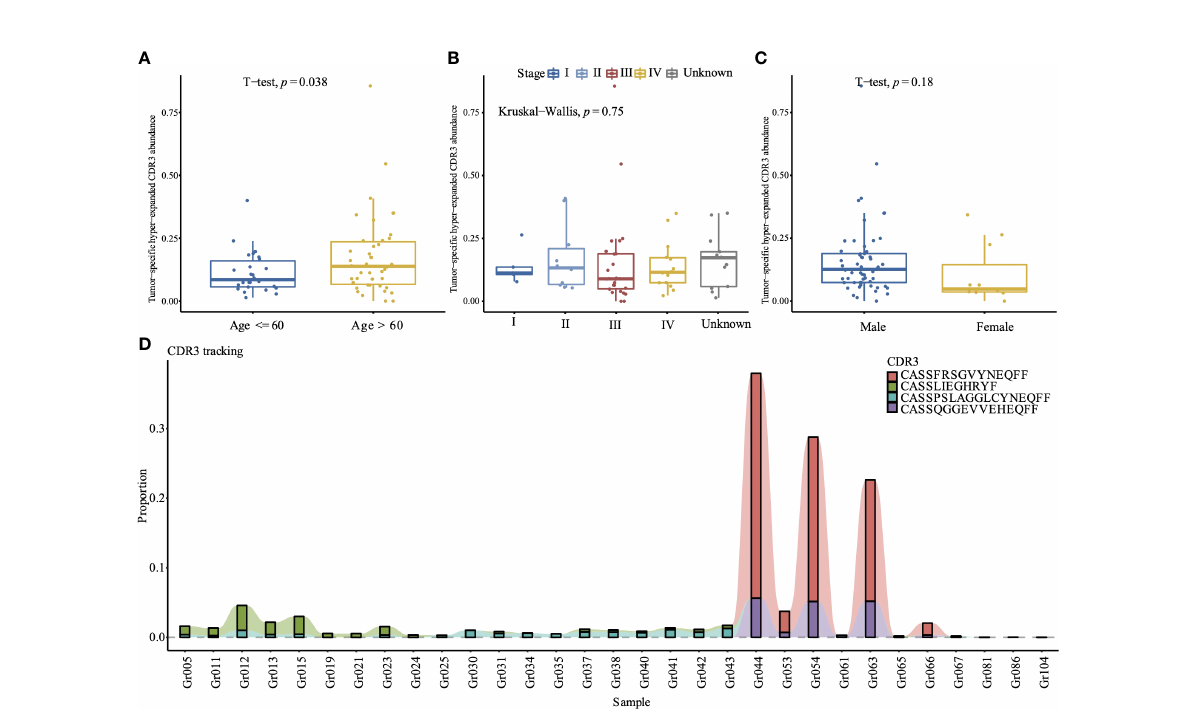
FIGURE 3 Comparison of the tumor-speci fi c hyper-expanded CDR3 abundance between different age (A) , tumor stages (B) , and gender (C) in 68 tumor samples. (D) Tracking of top 4 hyper-expanded tumor speci fi c TCR CDR3. The y-axis is the proportion of each CDR3 among the repertoire, samples without these 4 CDR3 are